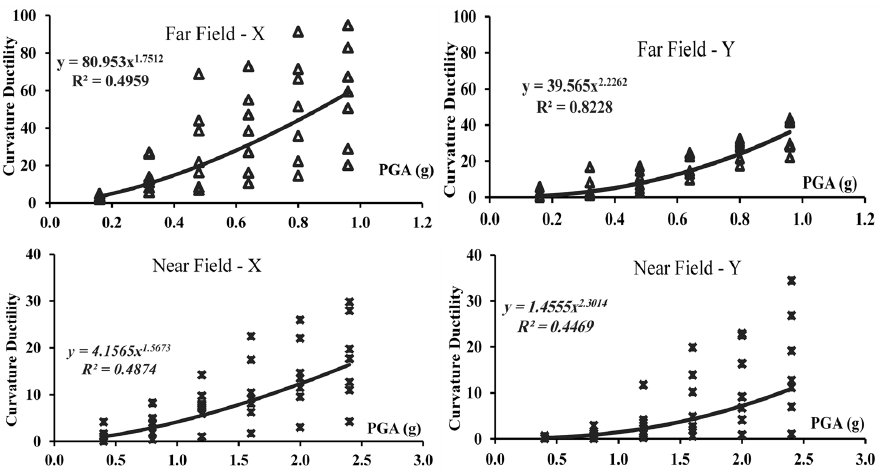
Figure 17. Incremental dynamic analysis (IDA) results of bridge bent curvature ductility (CD) demands using far-field ( top ) and near-source ( bottom ) input ground motions in the longitudinal ( left ) and transverse ( right ) directions of the benchmark bridge along with the power law equations.